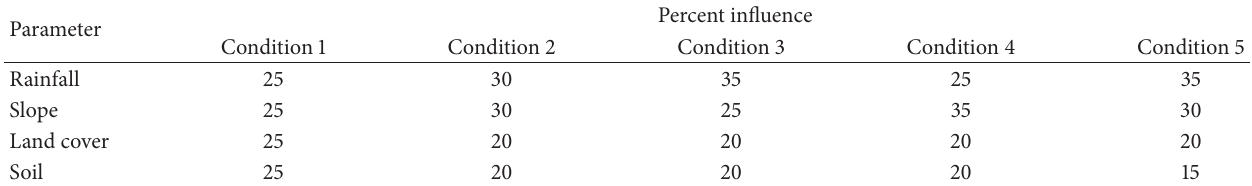
Table 3: Relative percentage influence factors ( 𝑤 𝑖 ) used in the weighted overlay